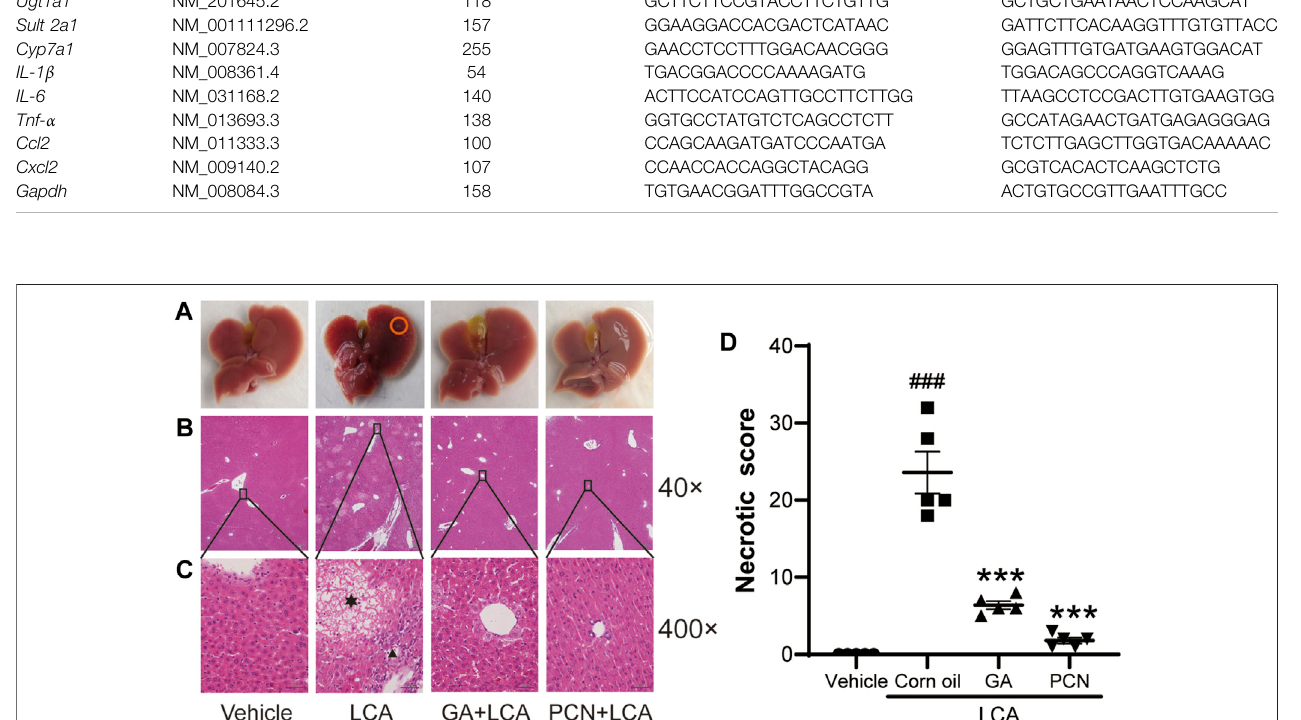
FIGURE1| Effects ofGAonhistopathologicalchangesofhepatic tissues. (A) Grossinspection,bileinfarcts aremarkedbyredcircles; (B) lowmagni fi cation(40×); (C) high magni fi cation (400×). Hepatocyte necrosis is marked by asterisks, and portal in fl ammation cells are marked by arrowheads. (D) Necrotic score of H&E-stained liver sections (low magni fi cation of 40×). Data are shown as mean ± SD ( n = 5). # p < 0.05 vs. vehicle group; ppp p < 0.001 vs. LCA